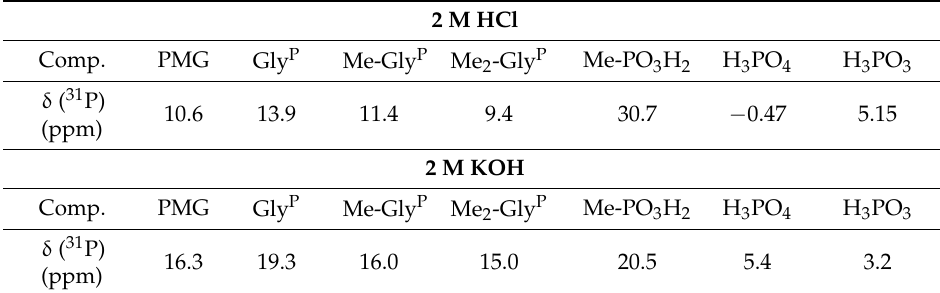
Table 6. 31 P Chemical shifts ( δ (ppm)) of PMG and its potential degradation products in acidic and basic solutions. 2 M HCl Comp.